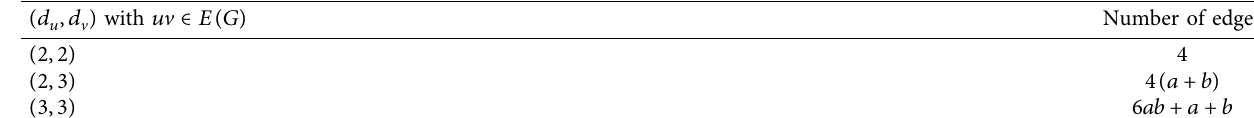
Table 8: Edge partition of T 2 [ a, b ]